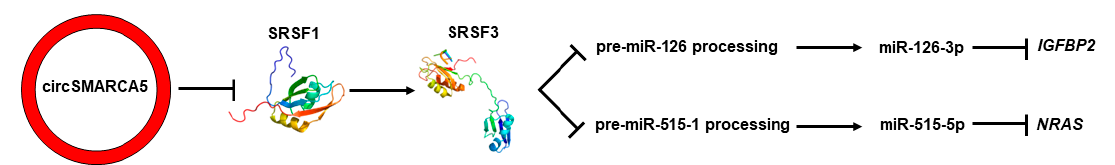
Figure 6. Schematic model of circSMARCA5-mediated upstream control of miRNAs 126-3p, 515-5p, and their mRNA targets IGFBP2 and NRAS .